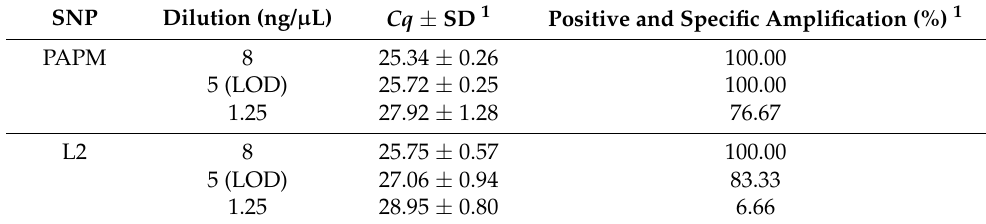
Table 7. Cq values for the tested dilutions in the preliminary screening to determine